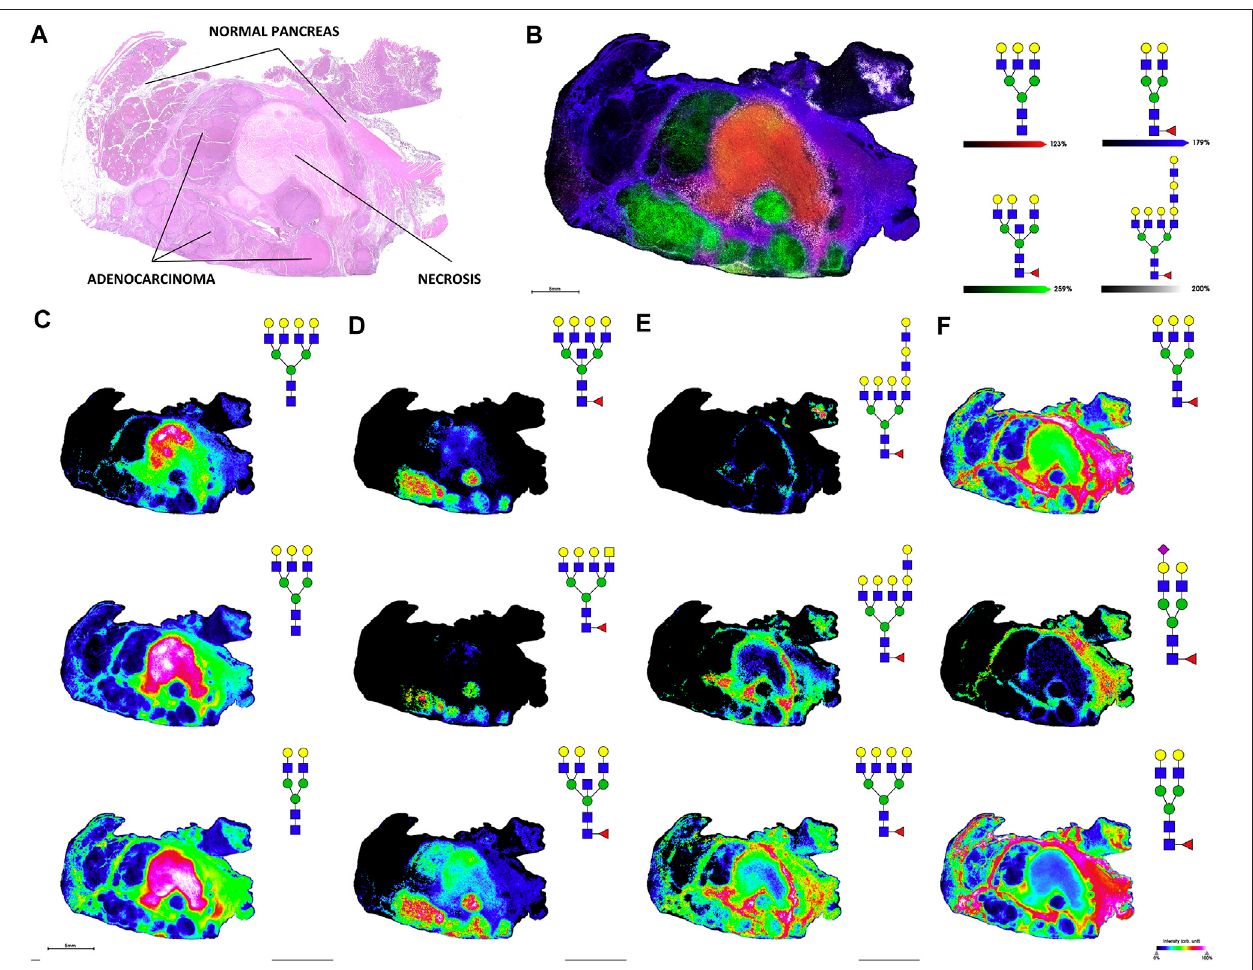
FIGURE 7 | H&E stain (A) and MALDI-FT-ICR MS images of N-glycans (B) , overlay of four glycans corresponding to necrotic tissue, adenocarcinoma, tumor margin, andadjacentnon-tumortissue; (C) ,glycansfromnecrotictissue; (D) ,glycansfromadenocarcinoma; (E) ,glycansfromtumormargin; (F) ,glycansfromadjacent non-tumortissue)releasedfromstage3pancreatictumortissue.ReproducedfromMcDowell,C.T.,Klamer,Z.,Hall,J.,West,C.A.,Wisniewski,L.,Powers,T.W.,etal. (2020). Imaging Mass Spectrometry and Lectin Analysis of N-Linked Glycans in Carbohydrate Antigen-De fi ned Pancreatic Cancer Tissues. Mol. Cell. Proteomics 20, 100012. doi: 10.1074/mcp.RA120.002256 under a Creative Commons CC-BY license